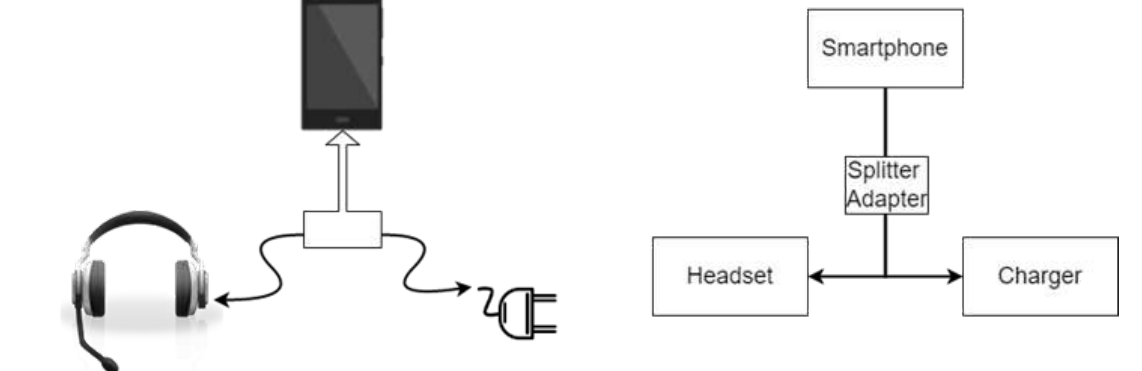
Figure 15. Scheme of how ordinary headphones are used with a splitter adapter and to charge the phone at the same time.